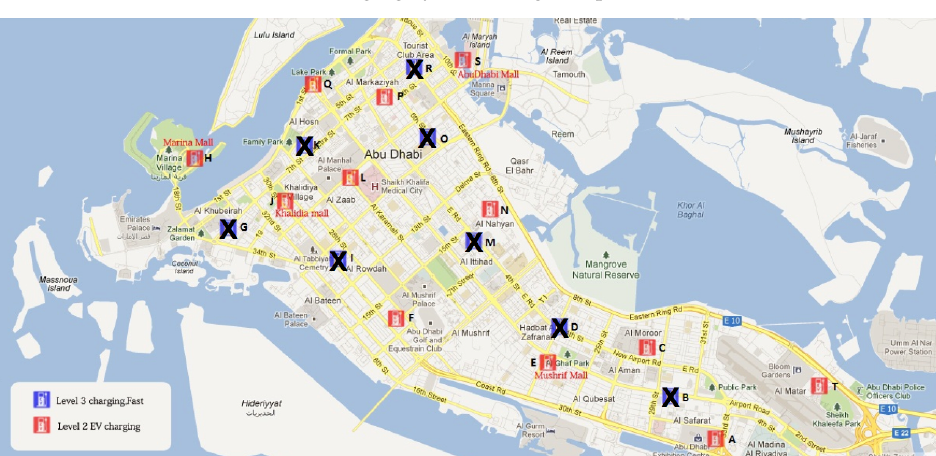
Figure 7. Limited Sparse Charging System Design